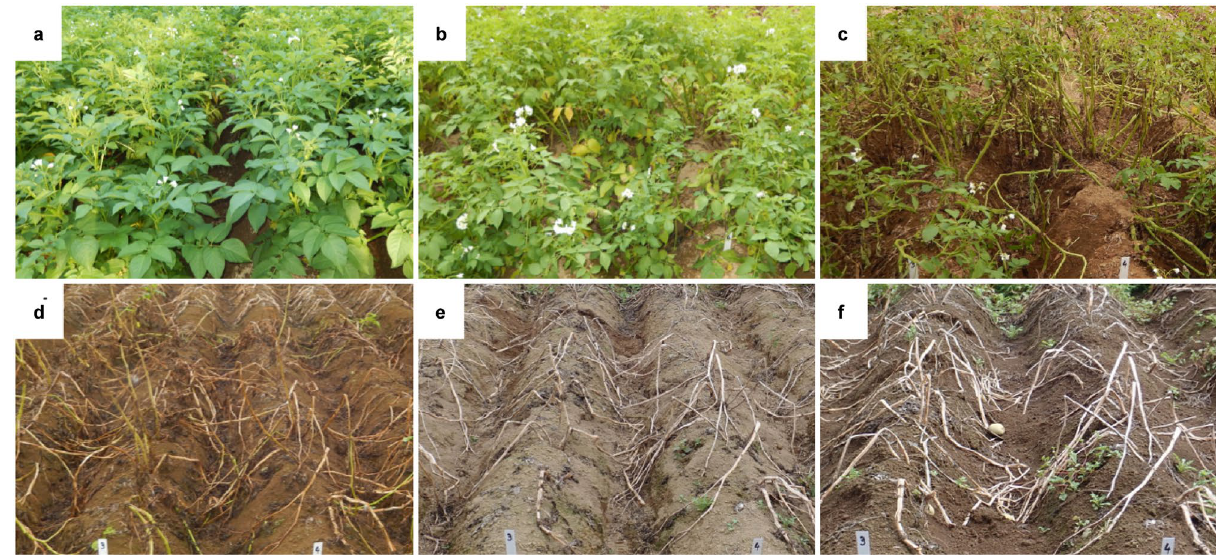
Figure 2. Symptom development at the same place in a non-controlled potato field in 2017. ( a ) First observation of late blight in the field on 7 July. ( b ) First observation of late blight on the sampled plants on 28 July. c An epidemic occurred on 5 August. ( d ) All plants died of late blight by 18 August. ( e ) The plants were dried by 25 August. ( f ) The final day of sampling on 15